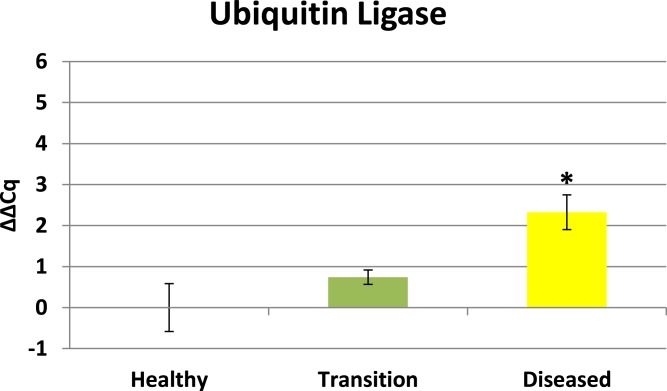
Ubiquitin Ligase expression.The ΔΔCq values represent transformed expression of ubiquitin ligase relative to PABP expression. An * represents a condition that was significantly different in expression (P < 0.01) relative to other conditions. Error bars represent ± SE.